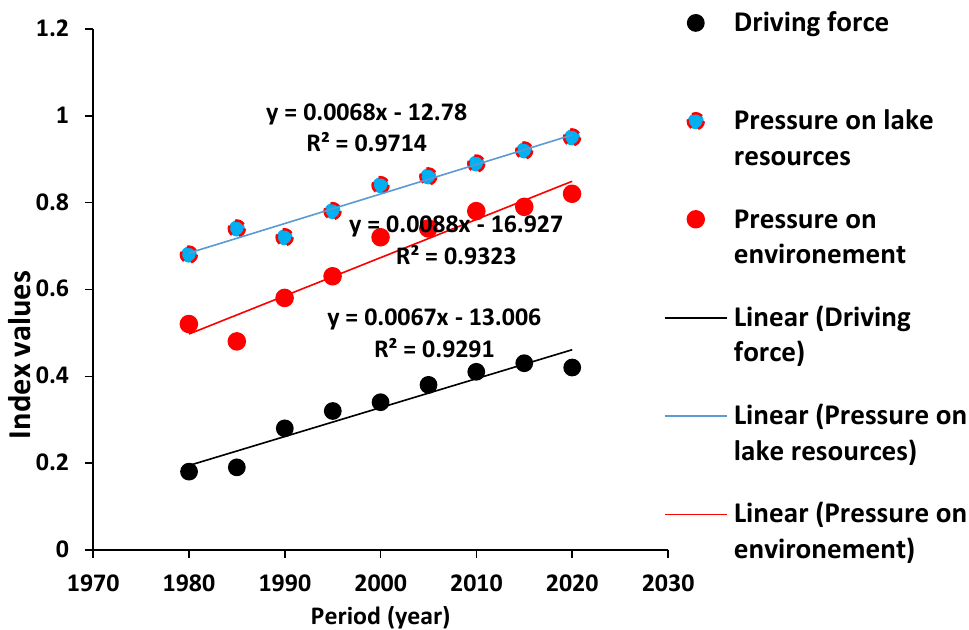
Figure 6- Inter-annual variation of the driver and pressure index. Figure 6. Inter-annual variation of the driver and pressure index. The inter-annual variation index followed the linear pattern demonstrated by the linear regression coefficients (R squared = 0.9). The theoretical explanation of the current observation is that these drivers and pressures will continue influencing the spatial and temporal changes of the